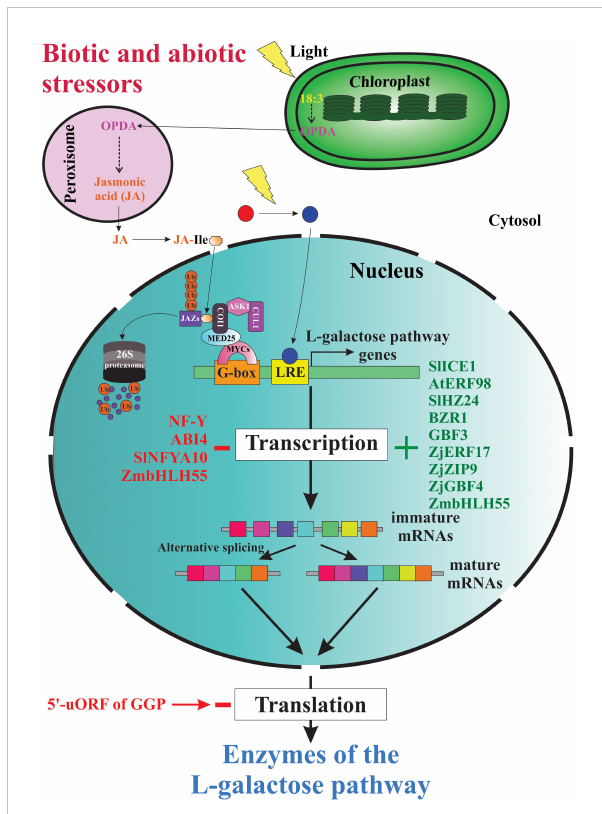
FIGURE 4 Genetic strategies for regulation of AsA biosynthesis in plants. When plants are under biotic and abiotic stress, they quickly up-regulate and/or down-regulate the expression of several genes involved directly or indirectly in AsA biosynthesis. Thus, several stressors induce the biosynthesis of jasmonic acid and other jasmonates, which starts intracellular signaling that fi nally induces the expression of AsA biosynthetic genes, translation of the corresponding enzymes, and increases the intracellular levels of AsA. The light, on its part, also starts an intracellular signaling activating transcription factors that bind with light-responsive promoter elements (LRE) and induces the transcription of gene-encoding enzymes of the L- galactose pathway. Until now, also were identi fi ed several transcription factors that activate (e.g., SlICE1, AtERF98, SlHZ24, BZR1, etc.) or inactivate (i.e., NF-Y, ABI4, SINFYA10, and ZmbHLH55) the transcription of the genes. In addition, alternative splicing is a probable mechanism involved in the regulation of AsA biosynthesis. Finally, the GGP gene is controlled via post-transcriptional repression by a conserved cis-acting upstream open reading frame (5 ’ -uORF) present in the 5 ’ -untranslated region of its